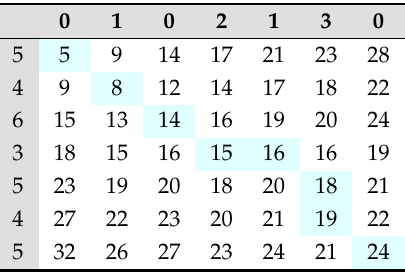
Table 1. Example of computation of the Dynamic Time Warping (DTW) distance matrix for two sequences, ’5463545’ and ’0102130’. 0 1